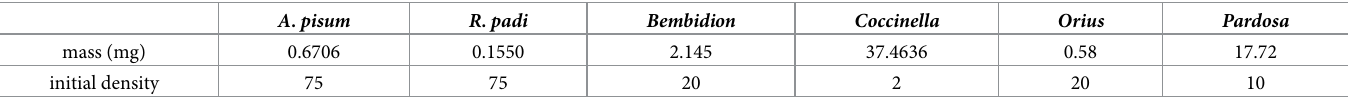
Table 2. The body masses and initial abundances for species in our study system. We note that the initial abundance for a single-species treatment is doubled, as if we were introducing two populations of the same